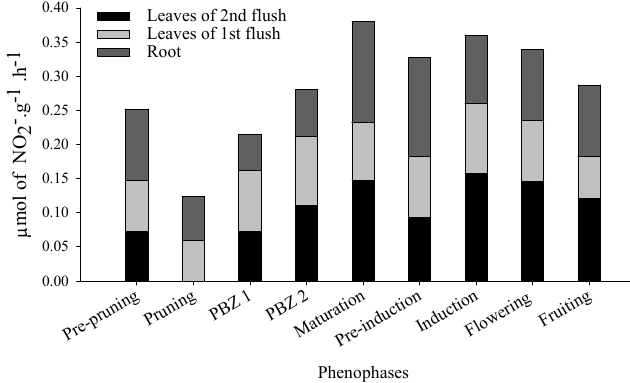
Fig. 3: Distribution of the nitrate reductase activity between leaves of the 1 st and 2 nd flushes and root of the ‘Palmer’ mango in the different phenophases along the vegetative and reproductive cycle in com- mercial orchard. PBZ 1: 12 days after PBZ application; PBZ 2: 32 days after PBZ application; NRa: nitrate reductase activity in μmol of NO 2 - ·fresh matter -1 ·h -1 .